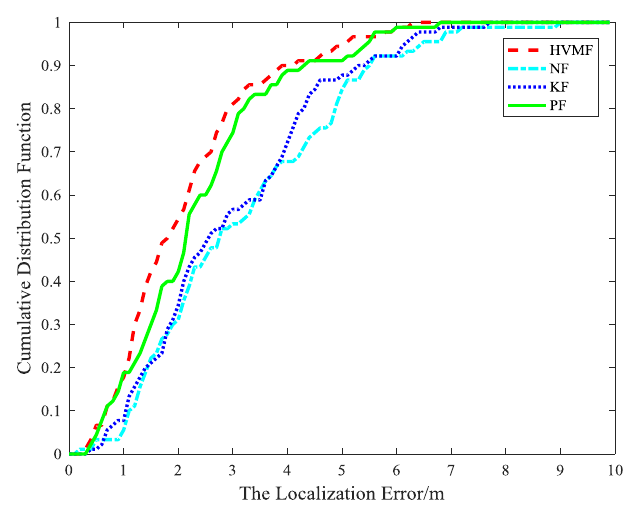
Figure 7. The localization error versus cumulative distribution function (CDF).